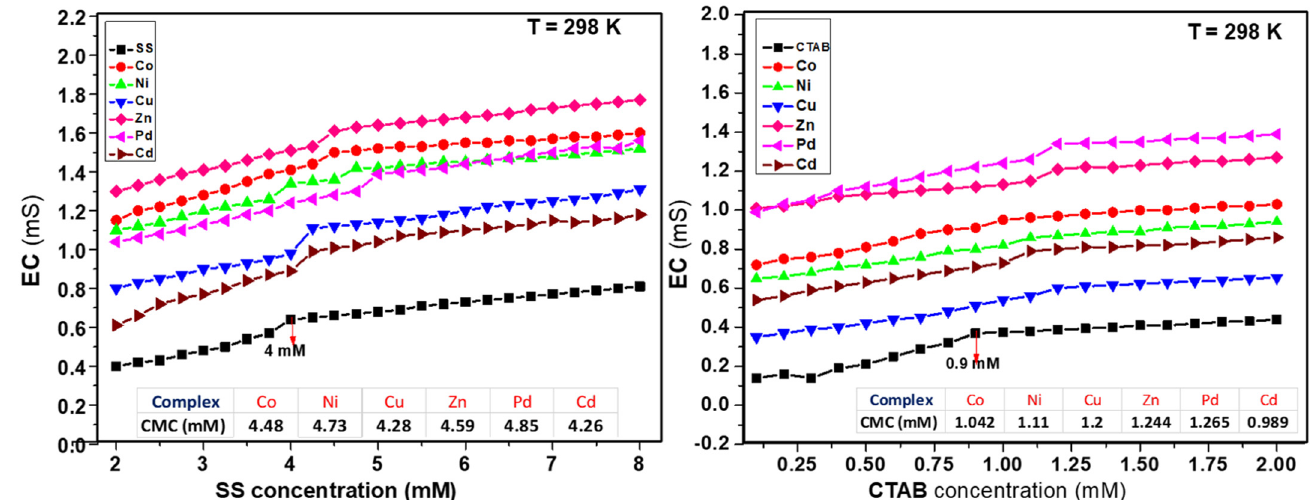
Figure 5. Plots of electrical conductivity vs. concentration of surfactants.